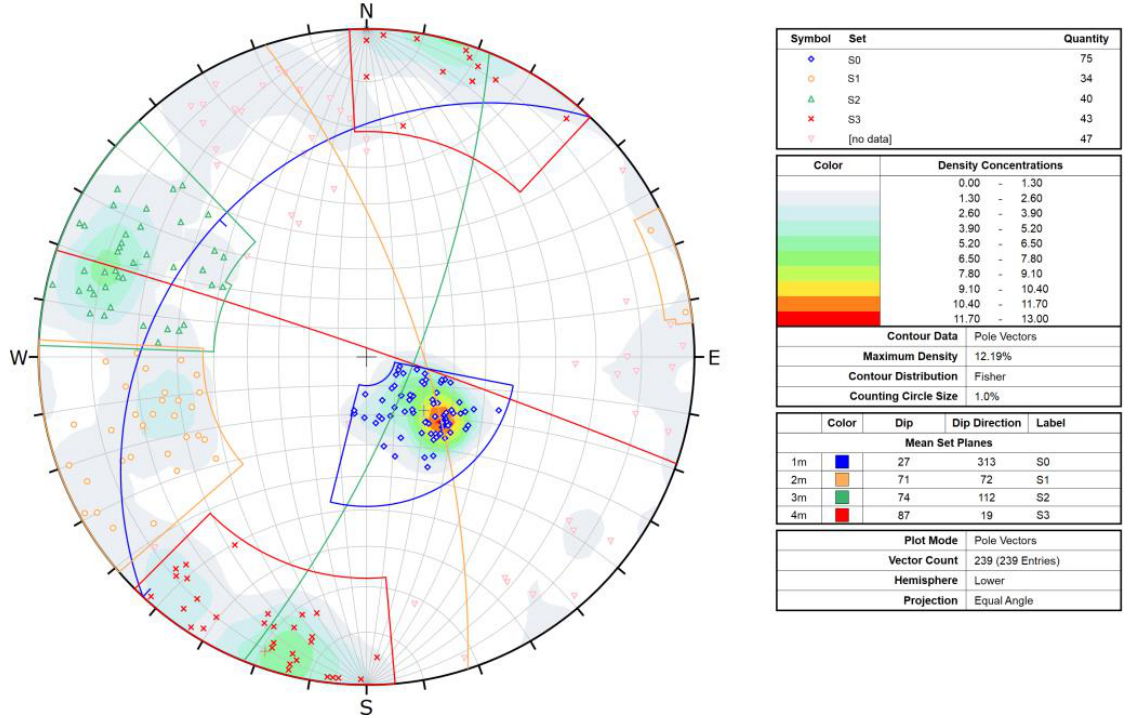
Figure 7. Stereonet of the structural measurements taken in the study area and shown in Figure 6. Colors of sets correspond to those of Figure 6.